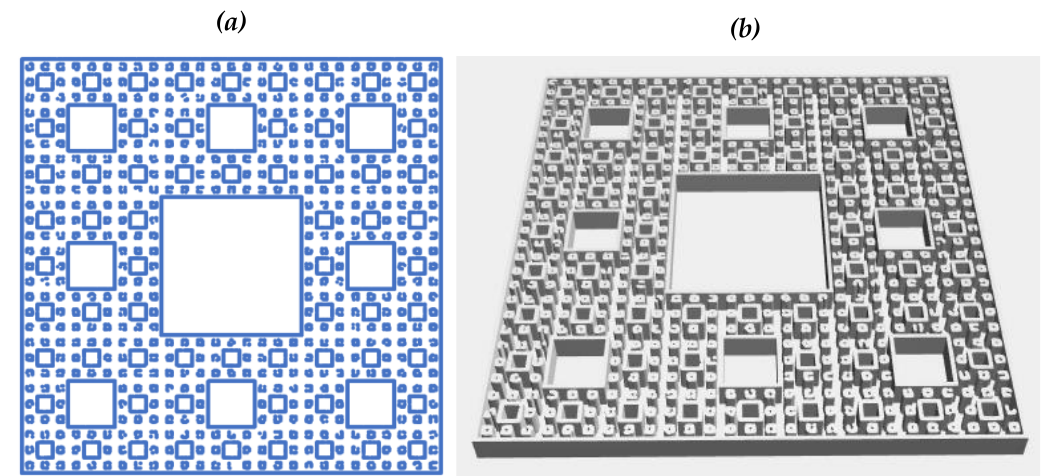
Figure 10. Point clouds controlled up to the fourth level and its solid CAD model: ( a ) the point clouds; and ( b ) the solid CAD model.